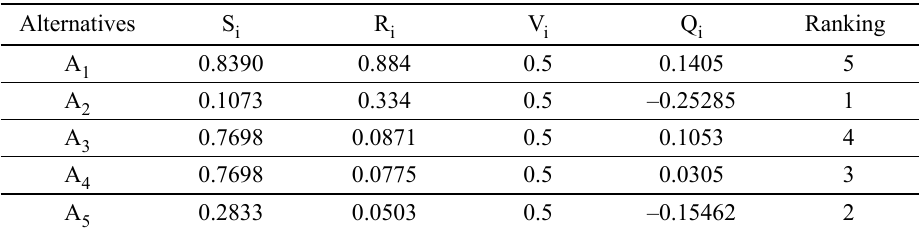
Table 10. Ultimate results and ranking of the